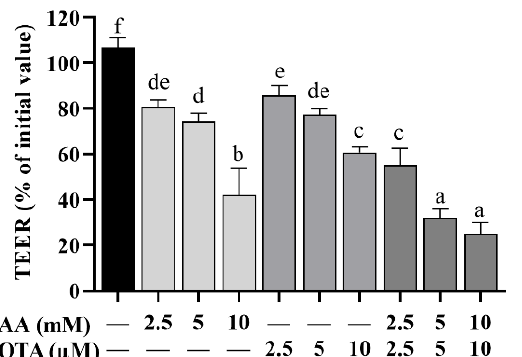
Figure 3. Effect of AA and OTA on TEER values. a–f Different letters indicate significant differences, p < 0.05.